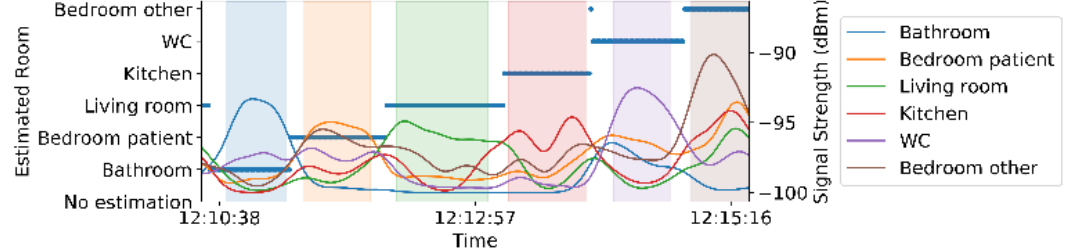
Figure 3. Example visualization of test run number 13 from home setup 8 where the proposed tracking algorithm has 100% accuracy. Ground truth location based on mobile application labeled with shaded background patches; processed beacon data indicated by the colored curves linked to right y -axis signal strength in dBm; colors correspond to specific rooms as indicated by the legend; algorithm room location predictions indicated by horizontal blue bars in line with the left y -axis.